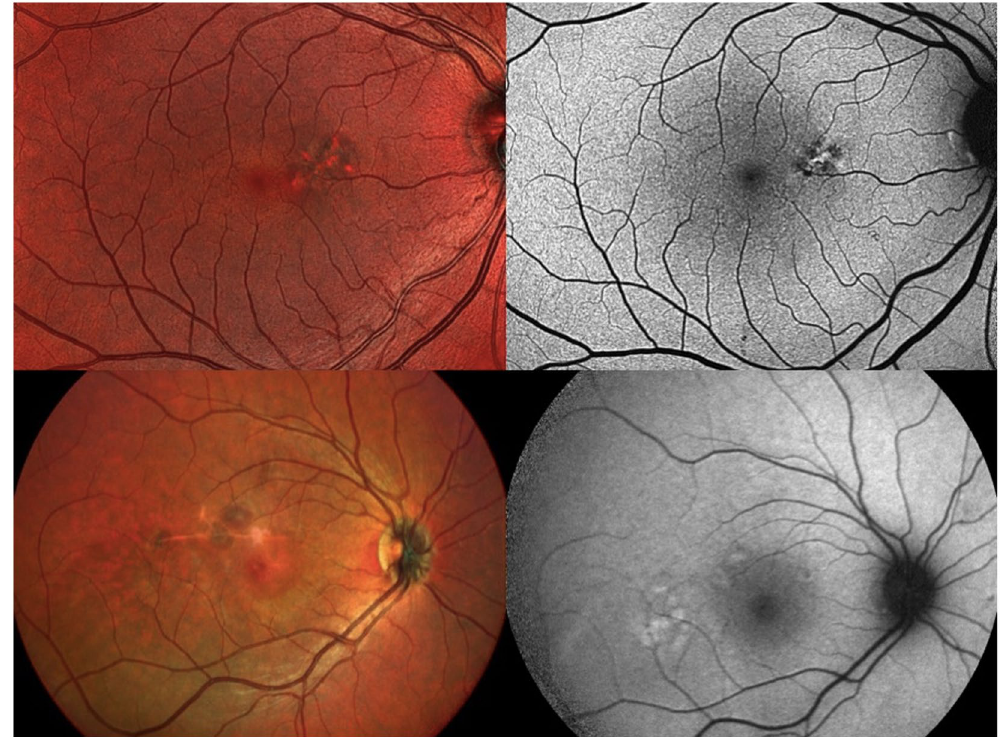
Figure 3. Imaging features of clinical findings in central serous chorioretinopathy (CSCR) on multicolor imaging (MCI) and fundus autofluorescence (FAF) -Clinical findings on MCI (left) and their corresponding FAF images (right) are noted. A discrete patch of retinal pigment epithelium (RPE) atrophy is noted nasal to the macula in the top left and right images which is seen as an area with visible choroidal vasculature surrounded by altered reflectance on MCI and as a hypoautofluorescent area surrounding a central hyperautofluorescene on FAF. Focal dark green lesions noted superior and temporal to macula on MCI (bottom left) and the corresponding areas of focal hyperautofluorescence on FAF (bottom right) depict pigment epithelial